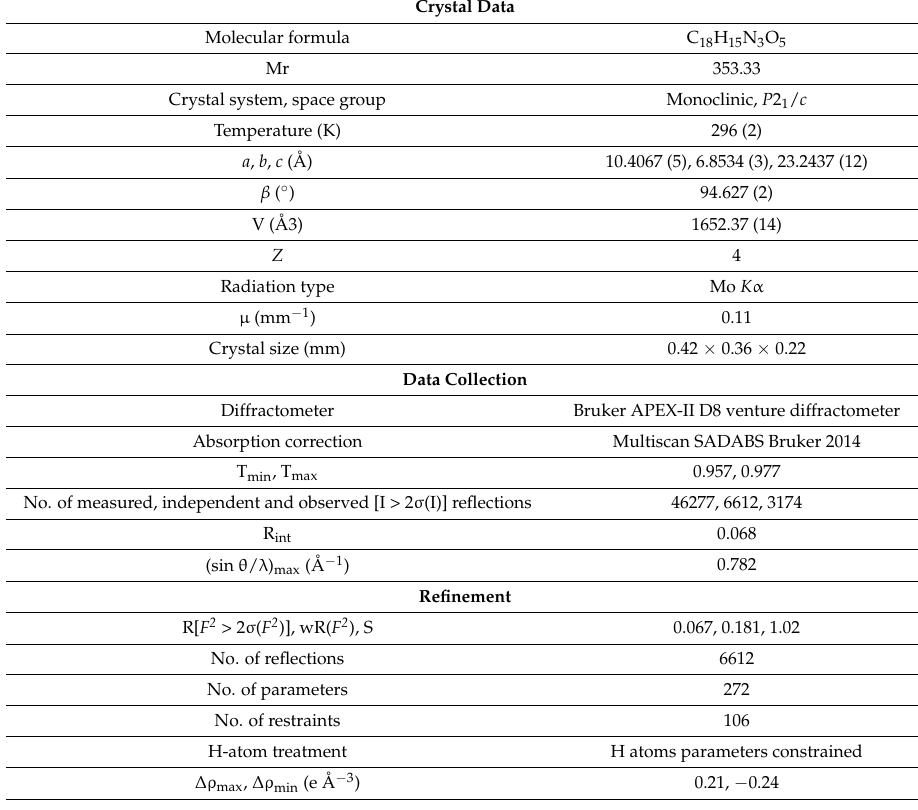
Table 1. X-ray experimental details of the oximino ester 5